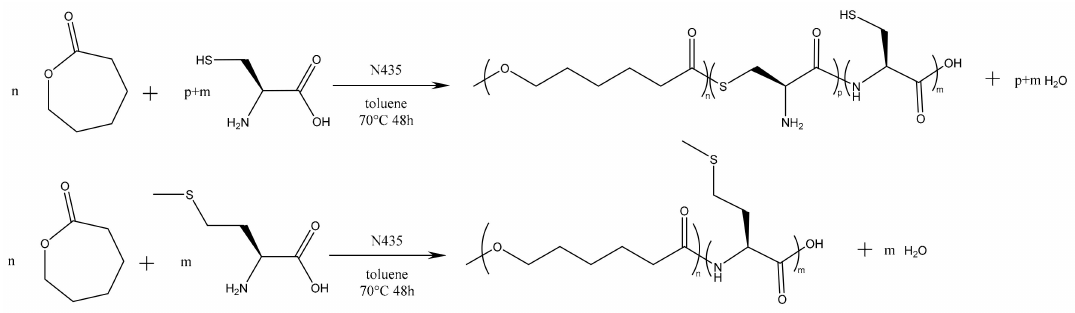
Figure 1. Preliminary direct approach for the polymerization of CL with unmodified amino acids.